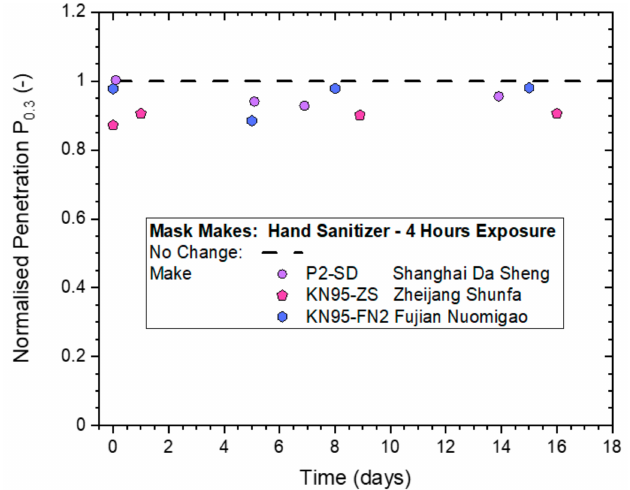
Figure 9. Normalized penetration P n0.3 from whole-mask screening testing of three different makes of disposable masks exposed to continuous hand sanitizing actions for 4 h (exposure level 4), measured immediately after treatment and then after storage in plastic bags for up to 16